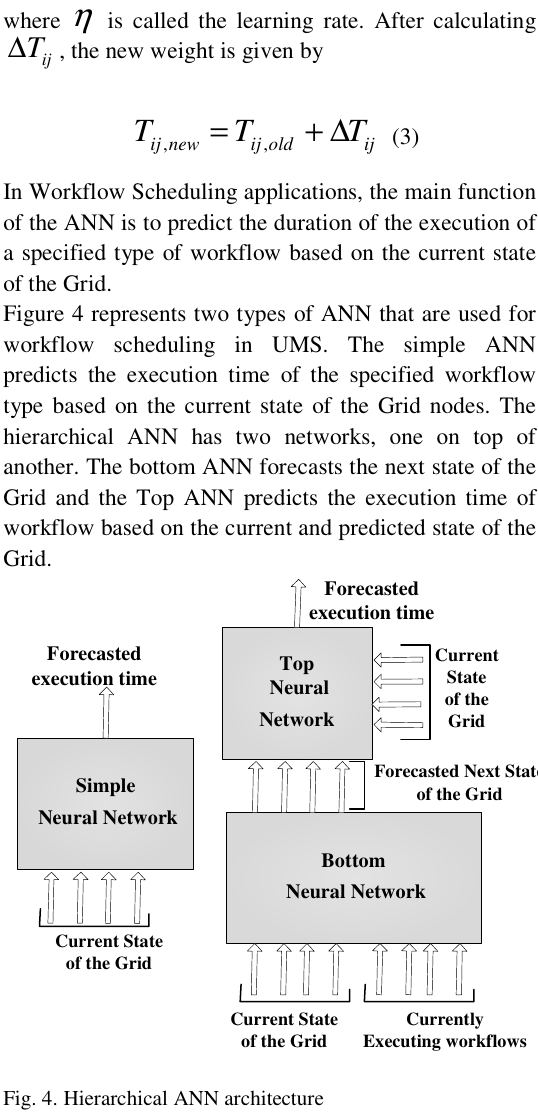
Fig. 4. Hierarchical ANN